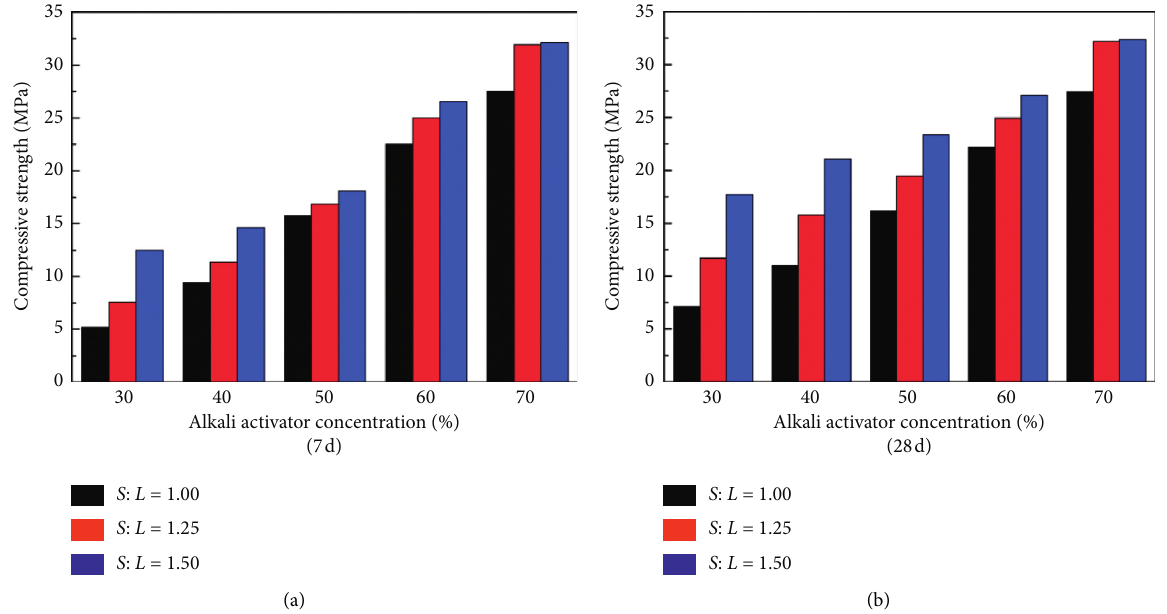
Figure 2: Influence of the solid/liquid ratio on the compressive